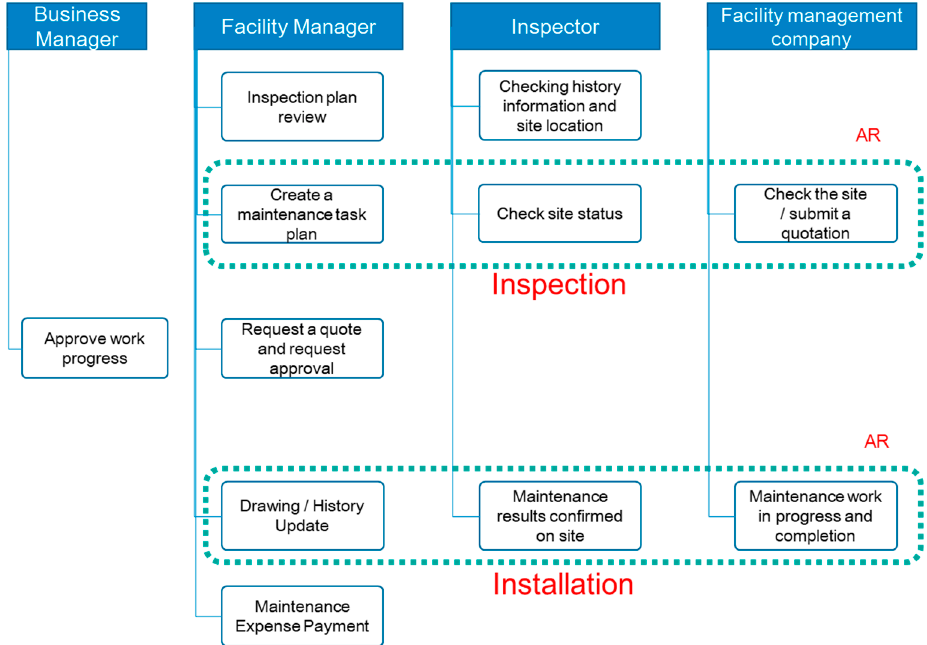
Figure 3. Identification of AR-applicable areas to existing FM tasks.